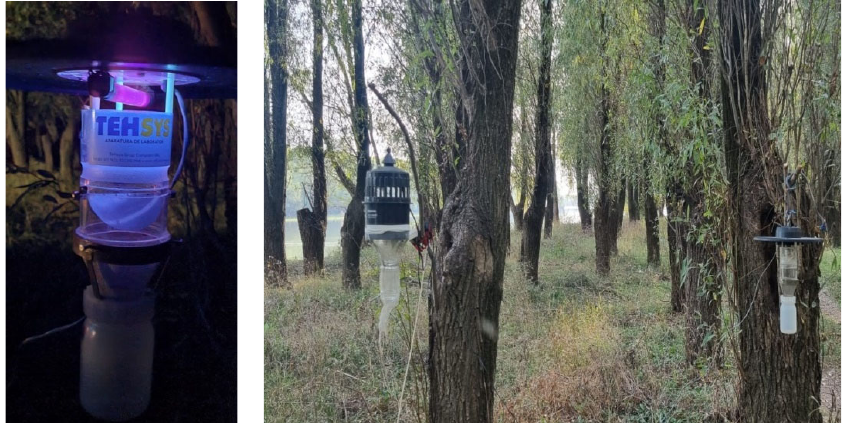
Figure 1. CDC Light Traps and the areas considered favorable for the development of the